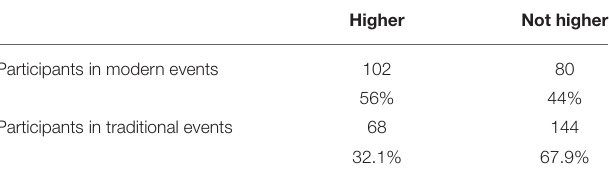
TABLE 9 | Level of education